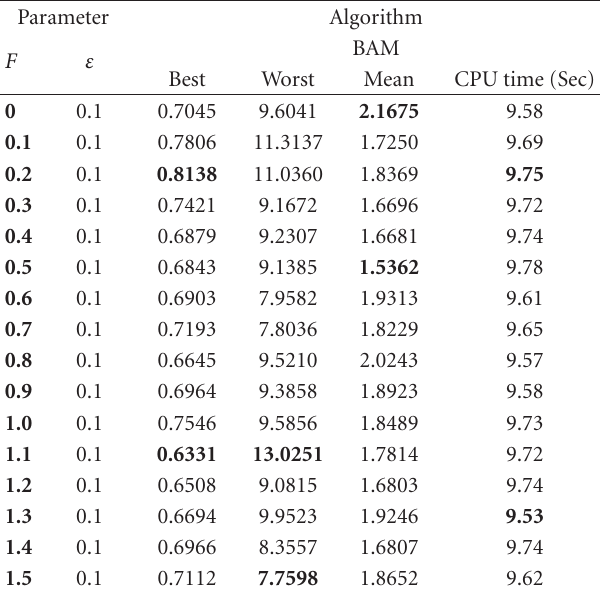
Table 18: Best normalized optimization results and average CPU time on UCAV path planning problem on di ff erent F . The numbers shown are the best results found after 100 Monte Carlo simulations of BAM algorithm.